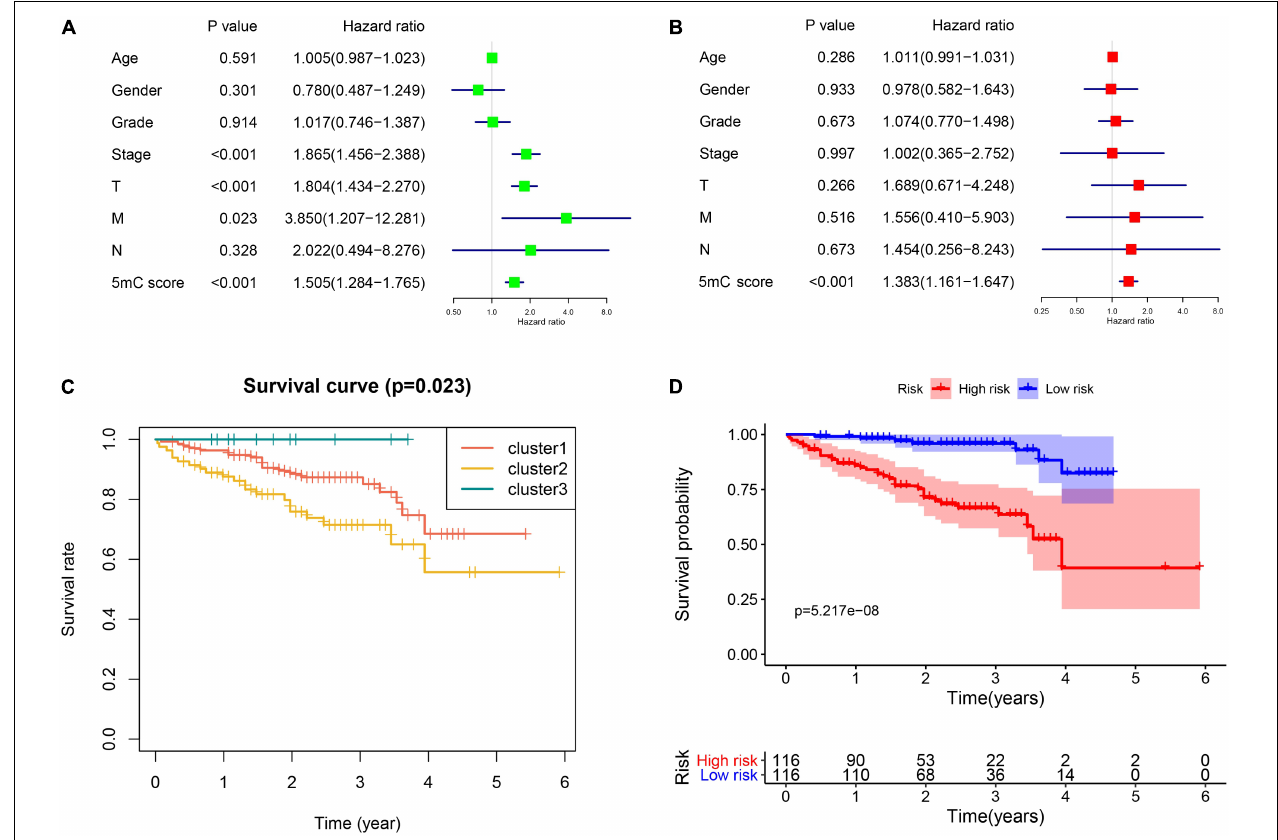
FIGURE 8 | Independent biomarker analysis and validation from the ICGC cohort. Panels (A,B) show the results of univariate and multivariate Cox regression analysis, respectively. (C) Survival analysis of the subtypes. (D) Survival analysis of 5mC